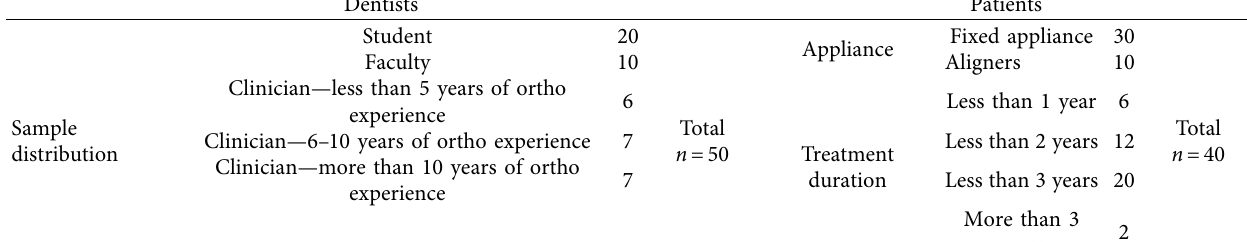
Table 1: Sample characterization of the clinicians and patients who answered the Google forms’ questionnaires. Dentists